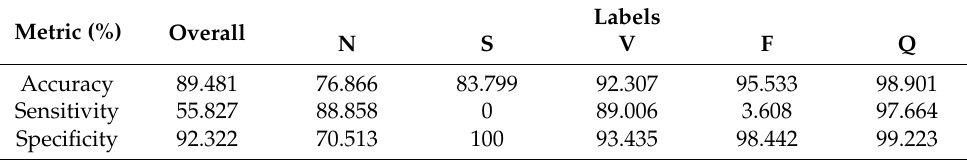
Table 4. Performance metrics of baseline heartbeat classification on test dataset.